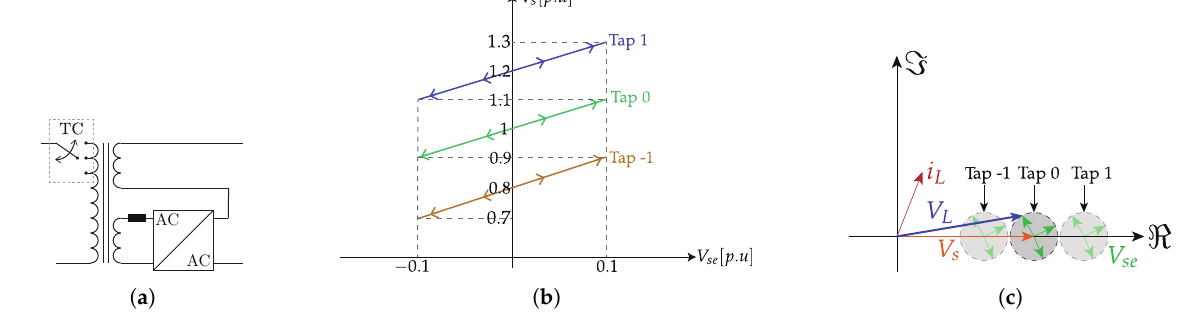
Figure 14. HDT with taps changers. ( a ) Diagram of a HDT configuration with taps changers systems ( b ) Operating region of the HDT output voltage versus the power converter converter output voltage ( c ) Complex plane operating region.